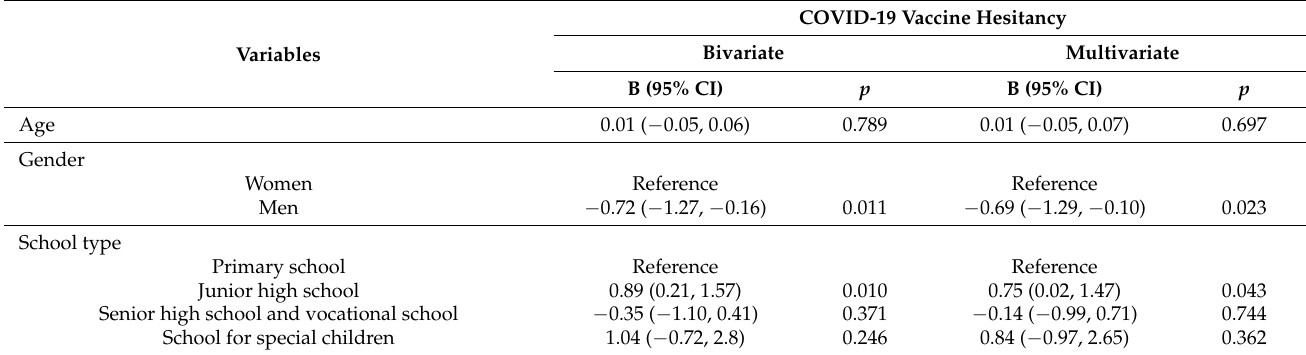
Table 4. Associated factors of COVID-19 vaccine hesitancy via bivariate and multivariate linear regression analyses ( n =